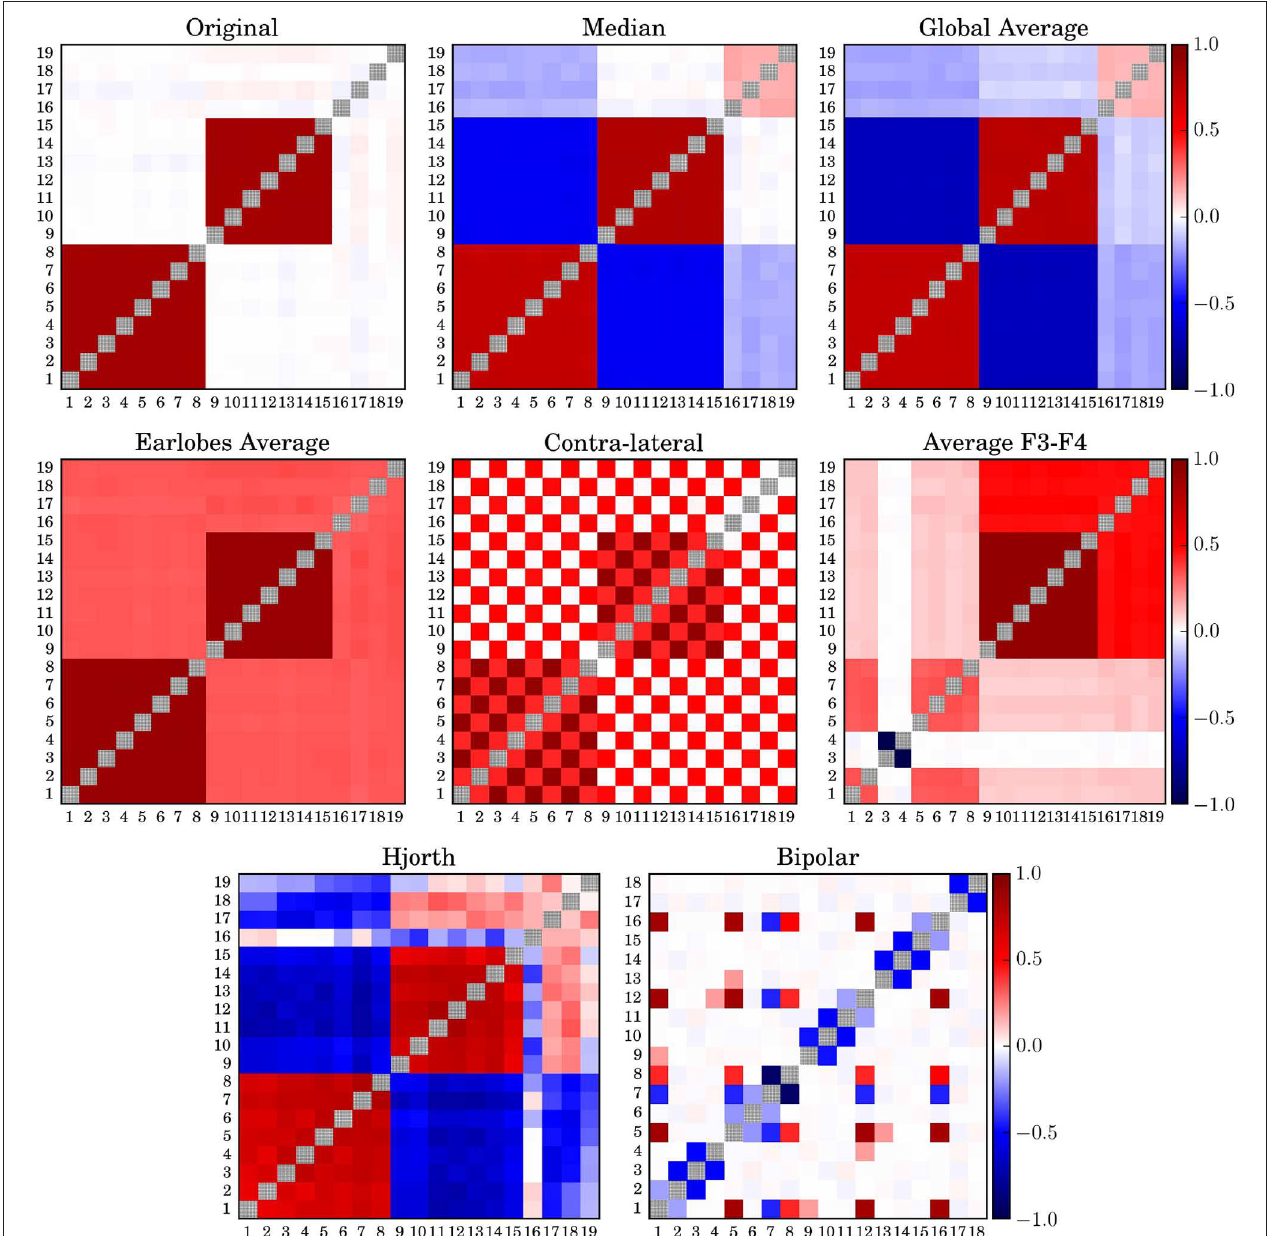
FIGURE 1 | Average correlation matrices derived from model 7 for different simulated EEG references. The diagonal elements of all matrices are drawn in gray in order to improve visibility.